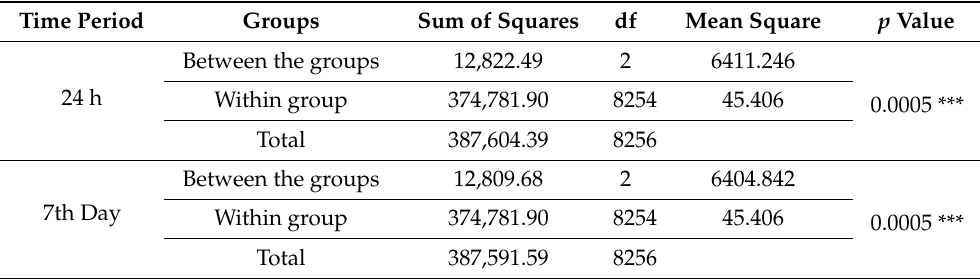
Between the groups